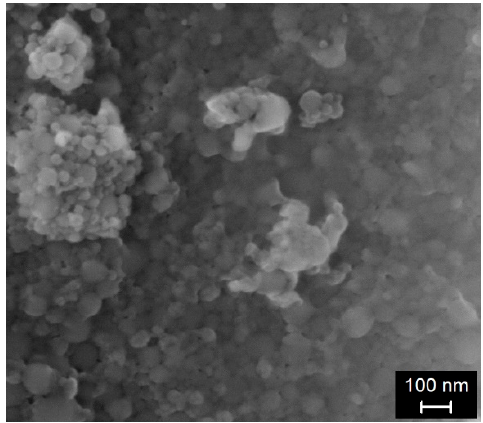
Figure 1. Scanning electron microscope (SEM) micrograph of nanosilica (NS).